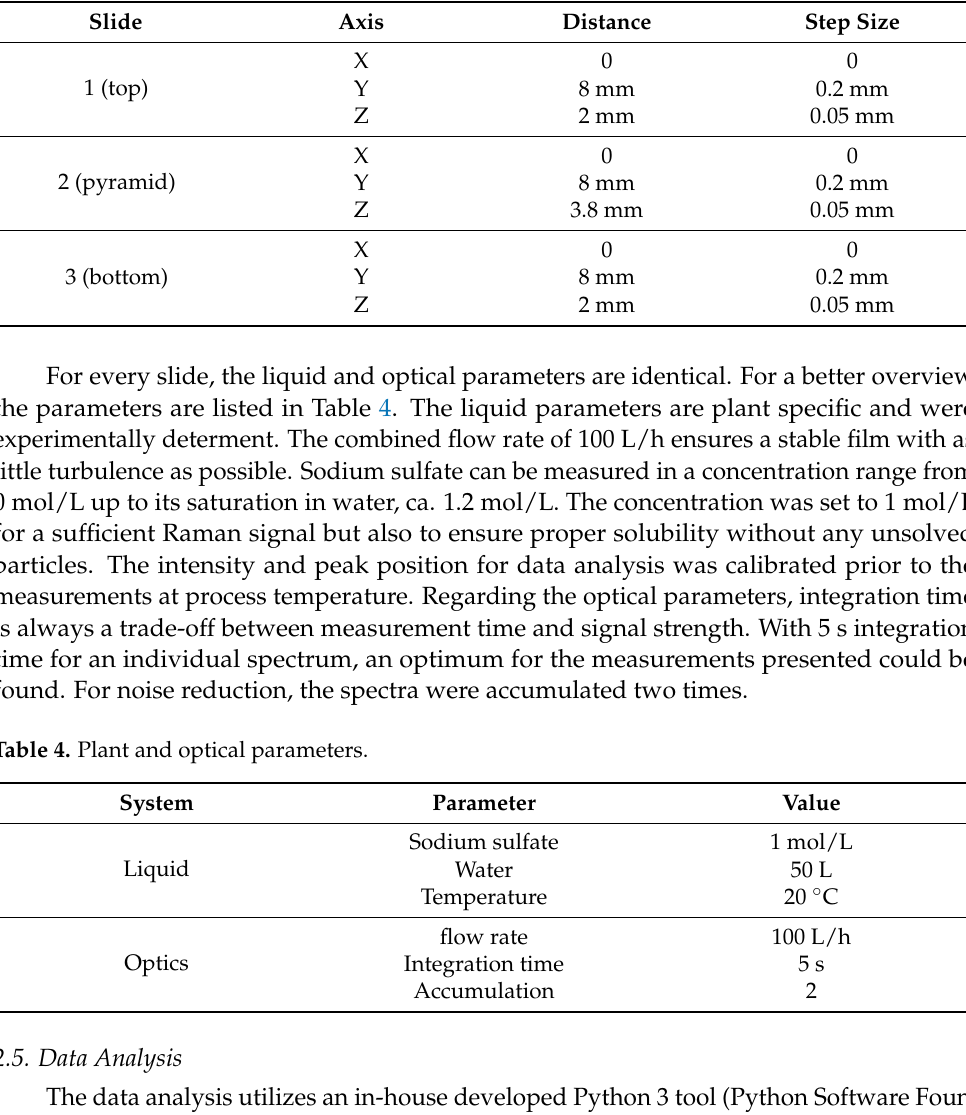
Table 3. Traversing parameters for the different 2D slides.